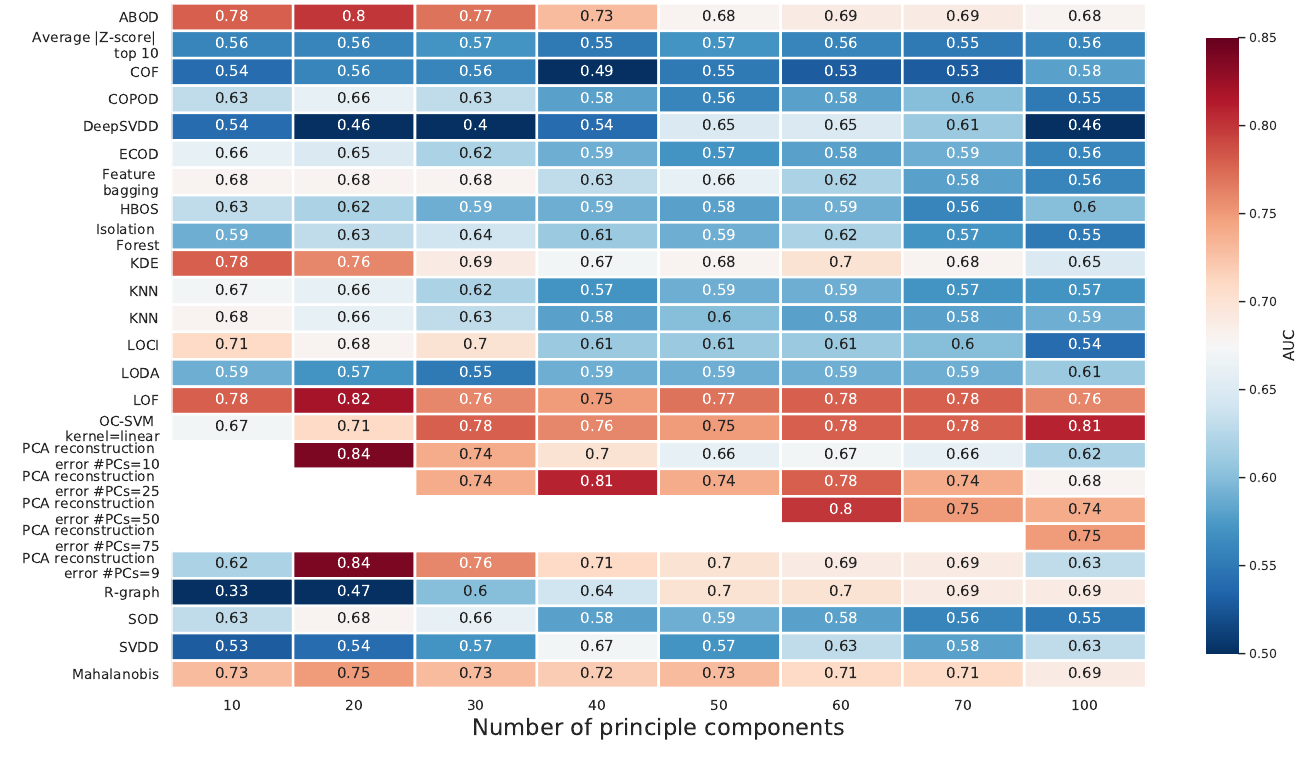
Figure A2. Average AUC (across 7 test CVs) for an increasing number of principle components after performing PCA analysis, similar to as described in Methods. Note that the number of PCs that PCA reconstruction error uses should always be lower or equal to the number of PCs that is used to (PCA) transform the dataset.